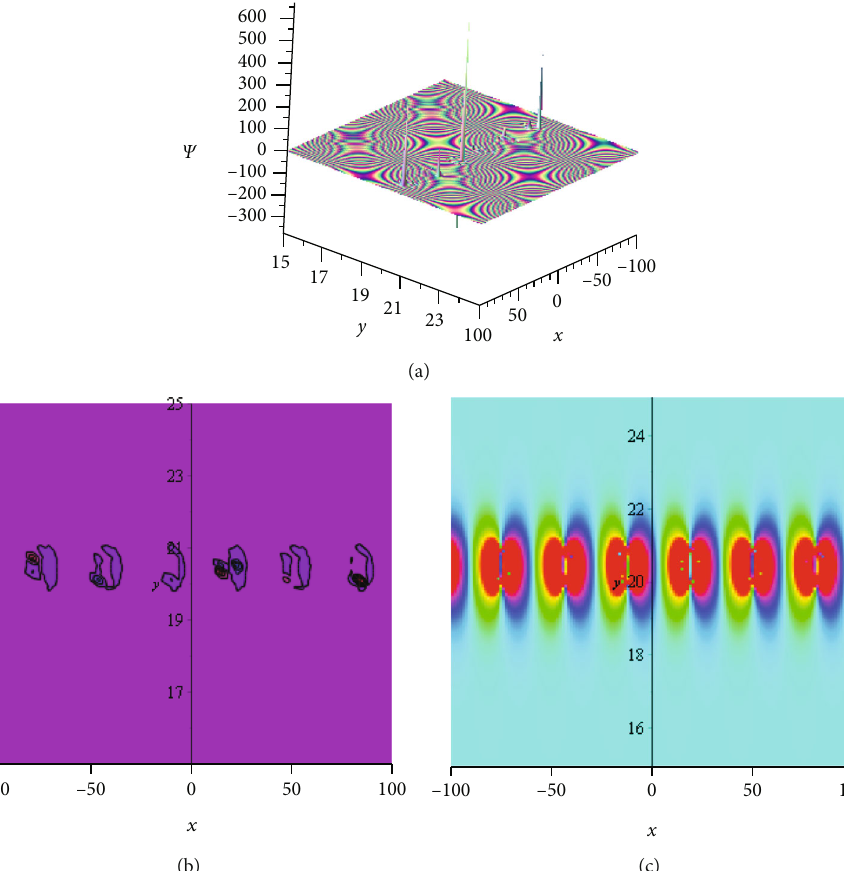
= : 2, Ω = 2, δ = 1, δ = 1 : 3, 4 9 1 2